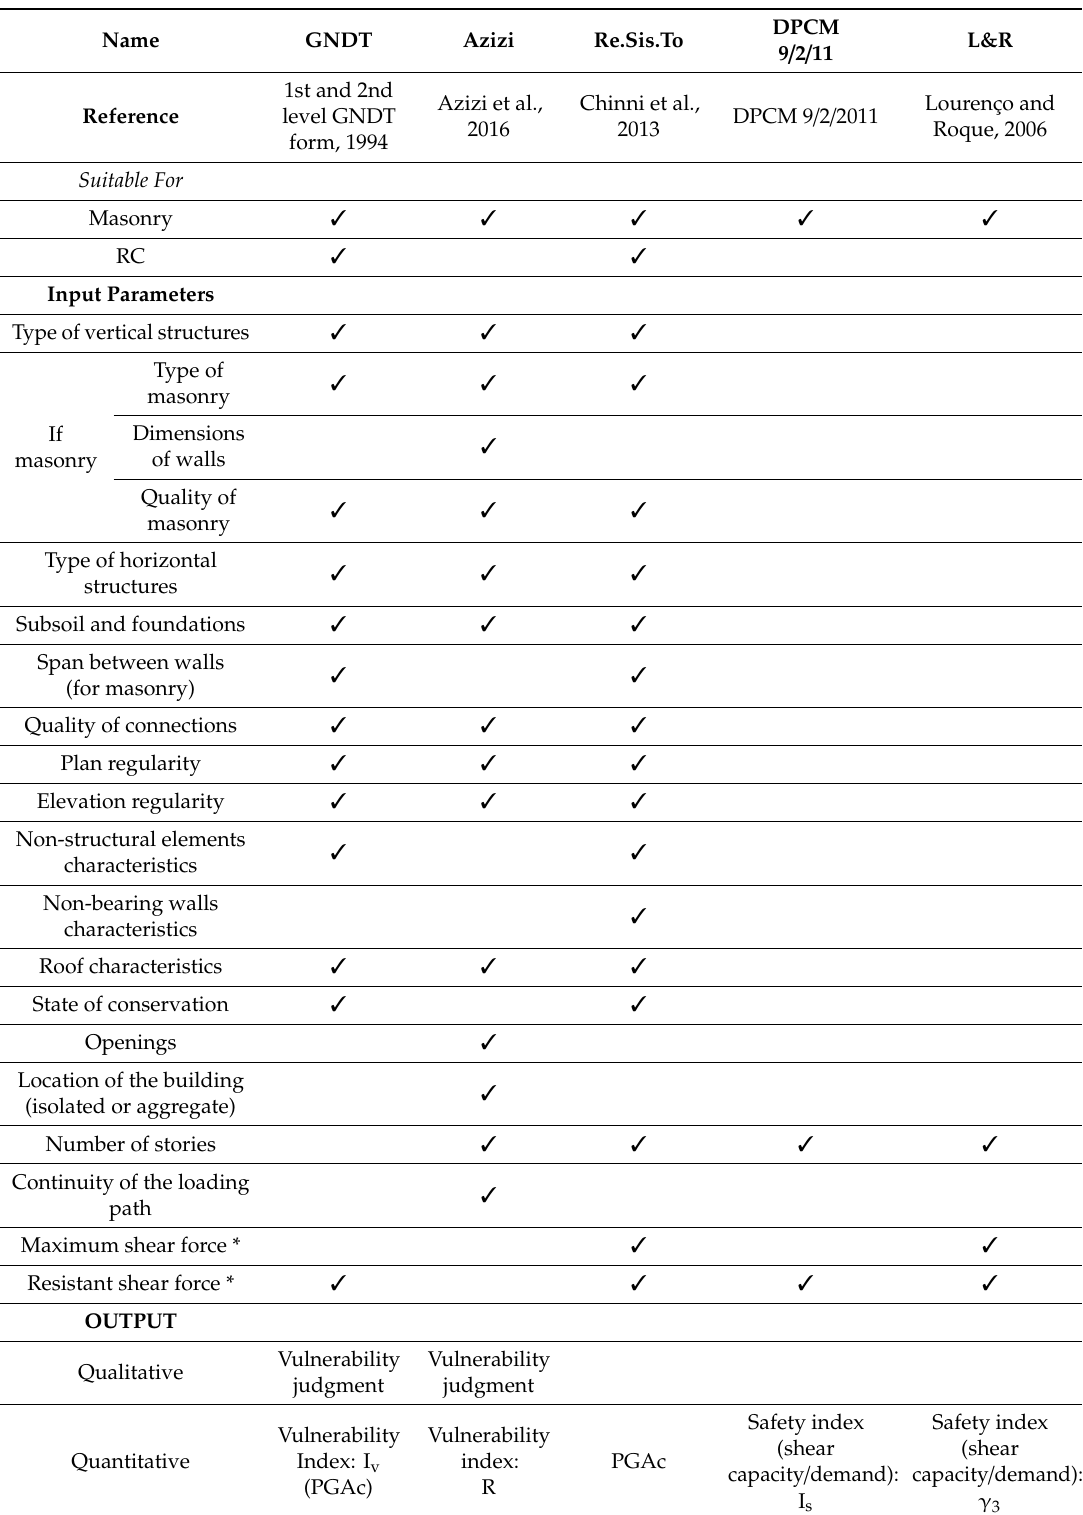
Table 2. Summary of simplified approaches belonging to Group